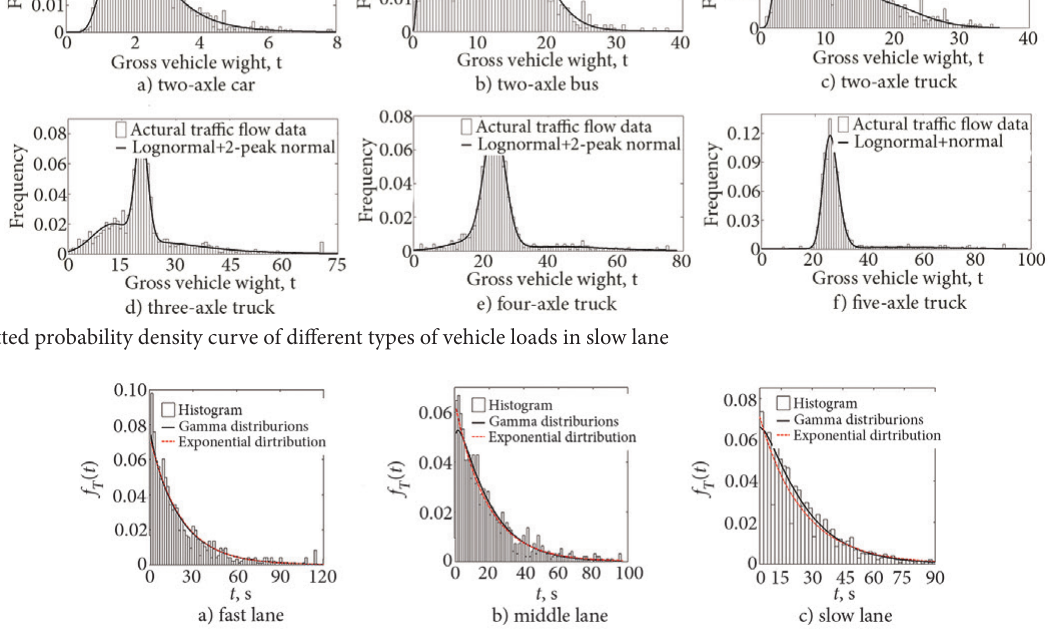
Fig. 6. Statistical analysis of vehicle